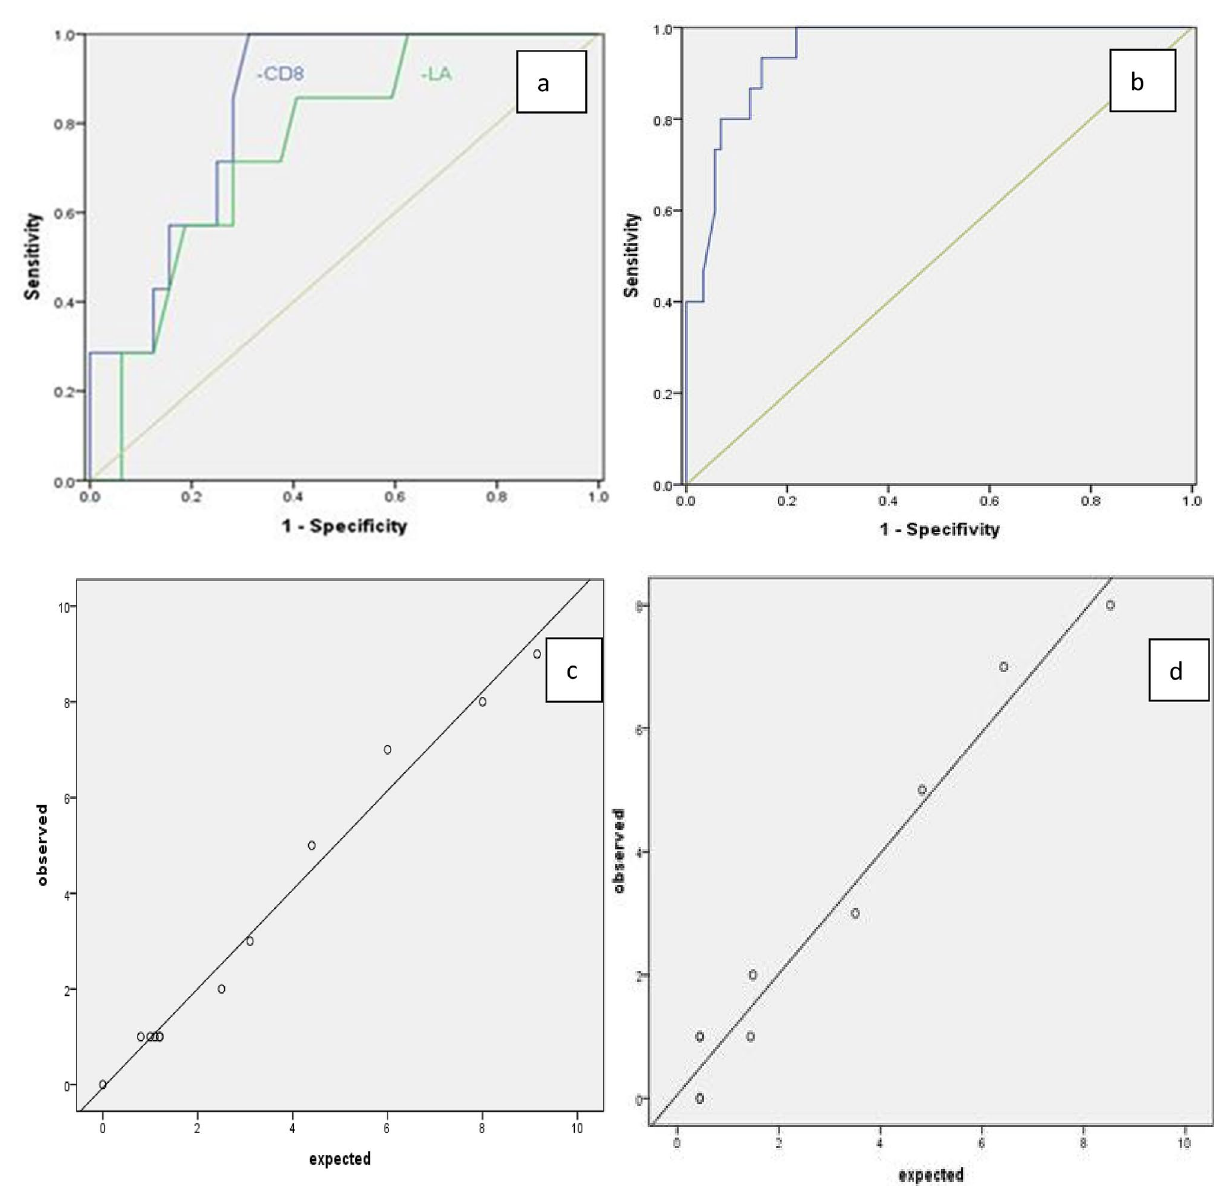
Figure 2. ROC curve of independent influence factors La and CD8 + T cells in training set (a) and ROC curve of CD8 + T cells in validation set (b). Fitting curve of actual observation value and prediction model value of prediction model established by CD8 + T cells in training set (c) and in validation set